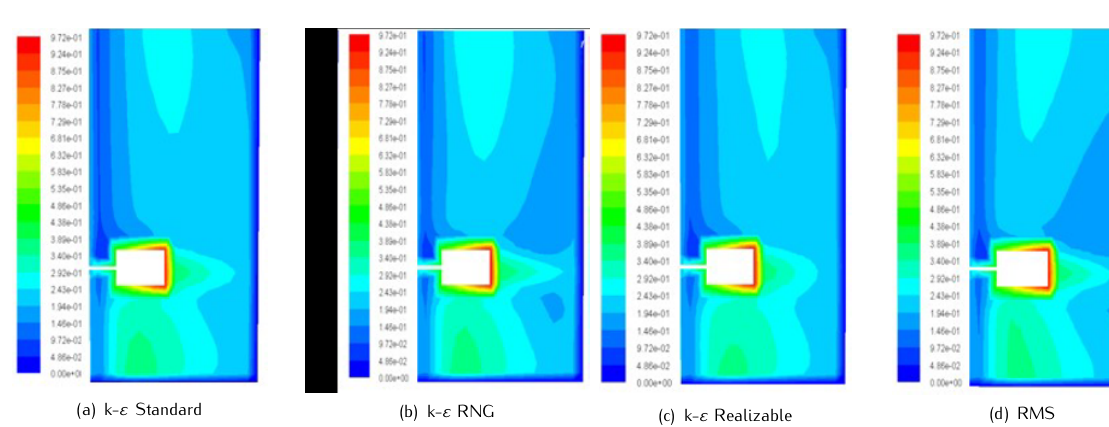
Figure 3. Distribution of the mean velocity in r-z plane.